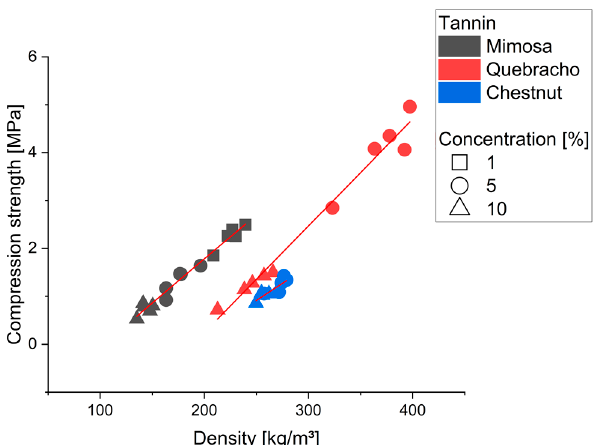
Figure 3. Compression strength of the different formulations according to their density.